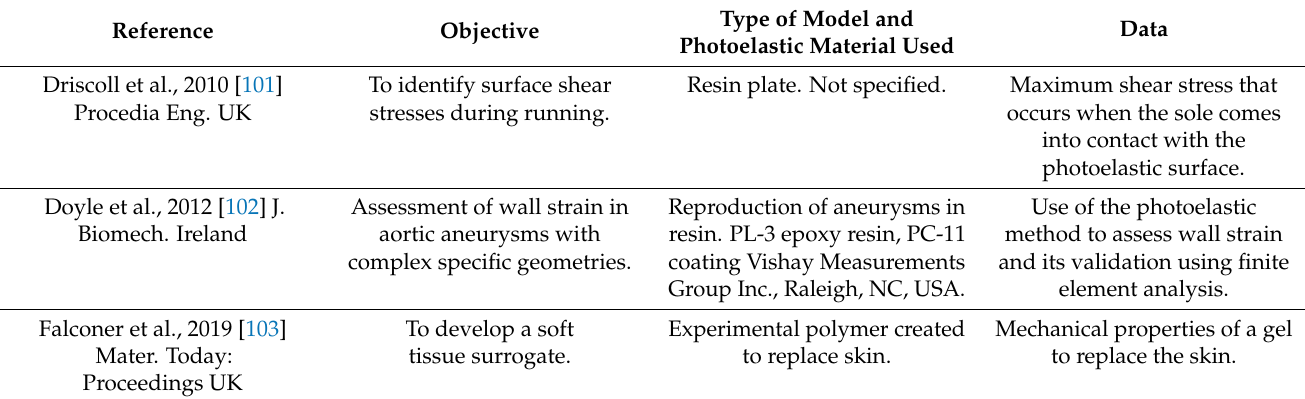
Table 12. Characteristics and findings of studies in other areas of application in